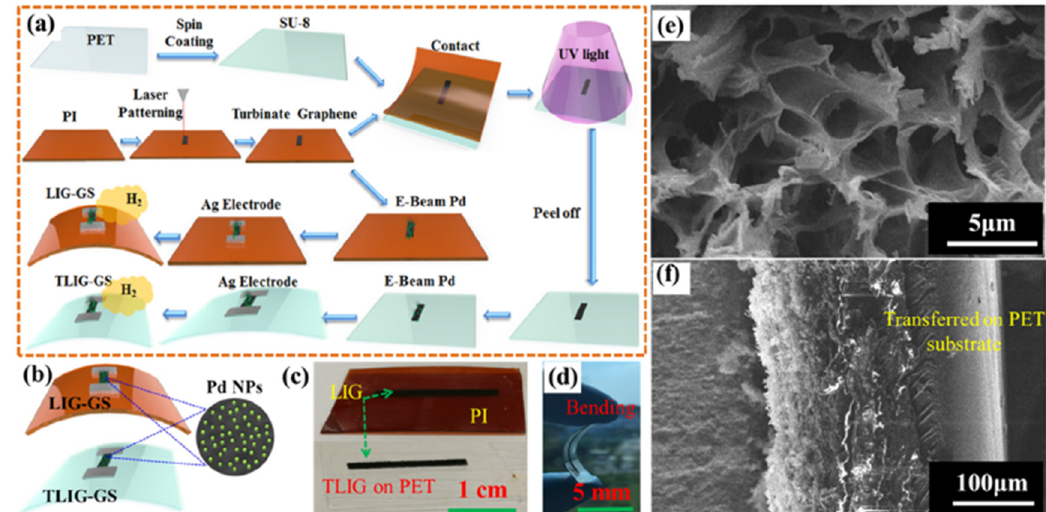
Figure 42. ( a ) The fabrication process of the laser-induced graphene gas sensor (LIG-GS) and transferred LIG-gas sensor (TLIG-GS). ( b ) Schematic of Pd NPs on LIG-GS and TLIG-GS. ( c ) Transferred line pattern of 3D porous LIG. ( d ) Image of bendable TLIG-GS. ( e ) Morphology of TLIG and ( f ) cross-sectional image of TLIG [180]. Copyright (2019), with permission from American Chemical Society.